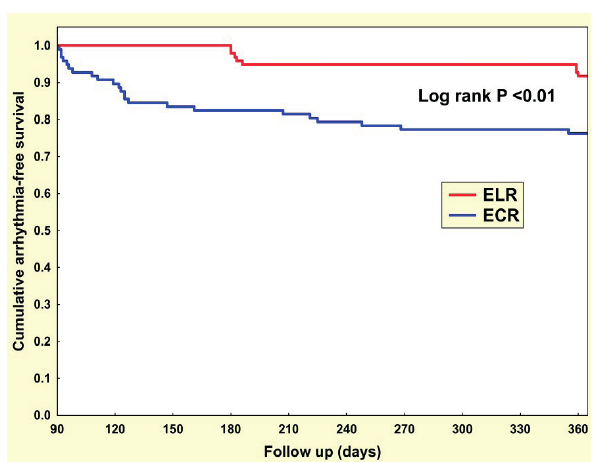
Fig. 1. Cumulative arrhythmia-free survival. Kaplan-Meier curves are displayed for single ablation outcome as as- sessed by ECG monitoring with episodic “card” recorder (ECR) versus episodic “loop” recorder (ELR). Monitoring with ELR at Months 6 and 12 detected significantly fewer recurrent AF/AT episodes as compared to monitoring with ECR. There were no arrhythmia episodes detected by ELR (and there were generally no AF/AT recurrences) that would not be known from daily ECR